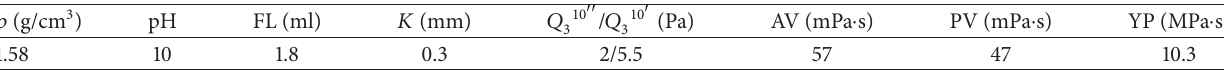
Table 2: Experimental FSDIF